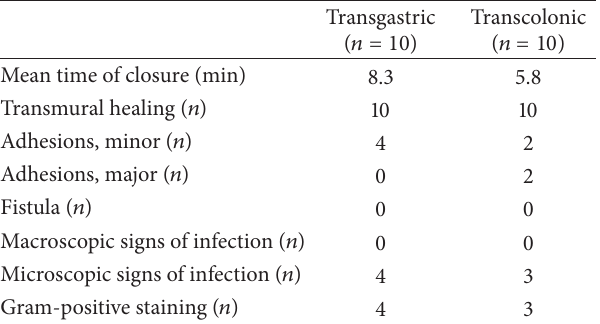
Table 1: OTSC closure, healing, and complications of NOTES